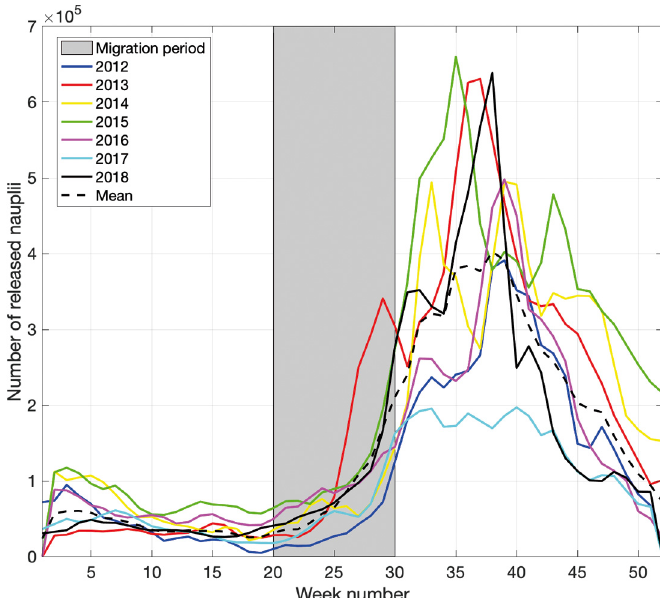
Fig. 2. Weekly mean salmon lice released from all farms (84 in to- tal) for the years 2012−2018 (solid lines) and the overall mean. The grey shaded area marks the migration period for salmon post-smolts from the Namsen